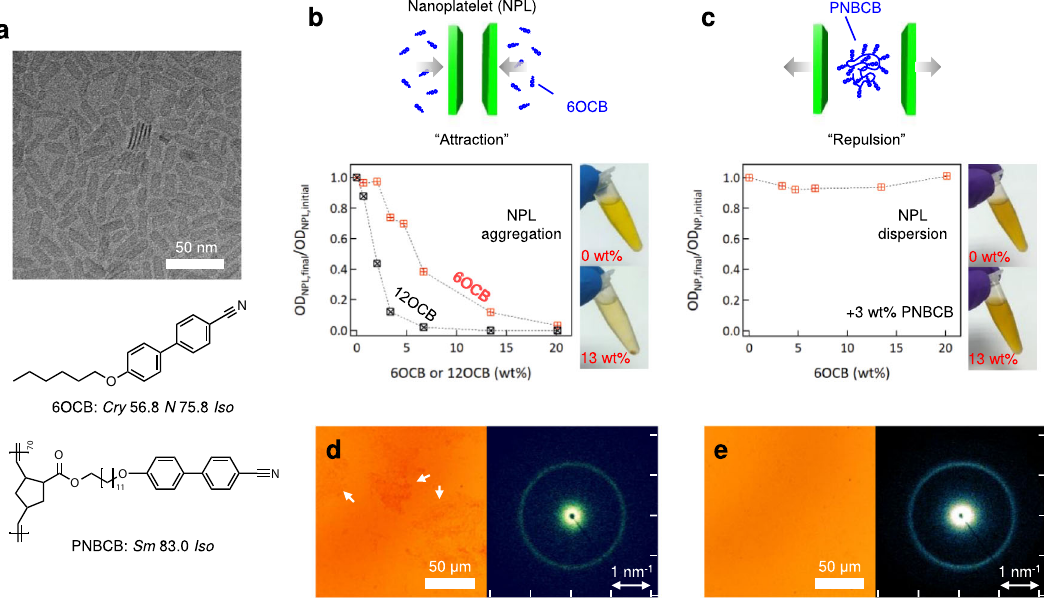
Fig. 1 Dispersion stability of colloidal CdSe nanoplatelets (NPLs) in solution in the presence of liquid crystals (LCs). a TEM image of CdSe NPLs and molecular structures of 6OCB and PNBCB and their phase transition temperatures. b Stability of NPLs in chloroform with the addition of 6OCB or 12OCB, which is evaluated by the decrease in optical density (OD) of supernatants after gentle centrifugation of the solutions. Photographs of NPL solutions (top) without 6OCB and (bottom) with 13 wt.% 6OCB. c Stability of NPLs in PNBCB/6OCB blend solutions as a function of the 6OCB concentration with constant 3wt.% of PNBCB, and photographs of NPL/PNBCB solutions (top) without 6OCB and (bottom) with 13 wt.% 6OCB in the presence of 3wt.% PNBCB. d Optical microscopy (OM) image of an isotropic NPL/6OCB composite and the small-angle X-ray scattering (SAXS) result. e OM image of an isotropic NPL/PNBCB/6OCB composite and the SAXS